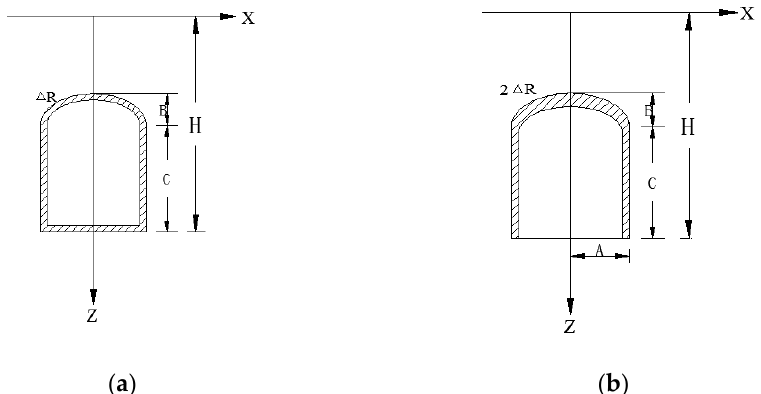
Figure 2. Horseshoe section of a tunnel: ( a ) uniform convergence and ( b ) non-uniform convergence. (Reprinted with permission from Ref. [32]. Copyright 2021 Springer Nature.).